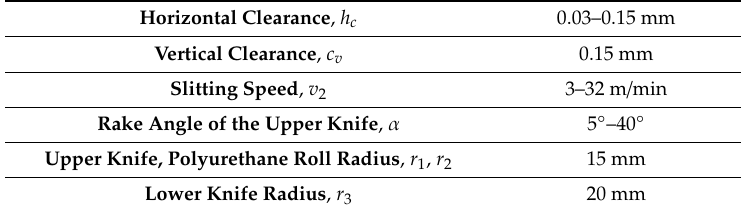
Table 3. Shear-slitting parameters.